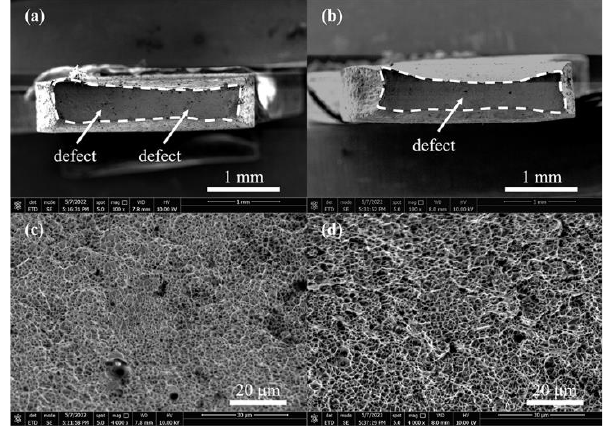
Figure 12. SEM of the fracture of the case: ( a , b ) LW 600 and HLAW 600-20, respectively; ( c , d ) higher magnification micrographs obtained from the Central areas in ( a , b ), respectively.